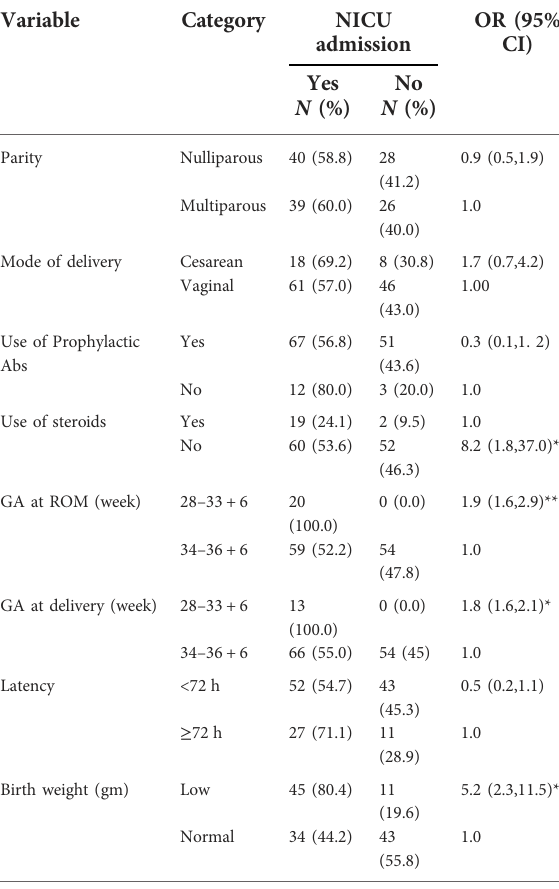
NICU, Neonatal intensive care unit; Abs, antibiotics; GA, Gestational Age; ROM, Rupture of Membrane. * , ** & *** indicate statistically signi fi cant difference at p <0.05, p <0.01 and p <0.001,